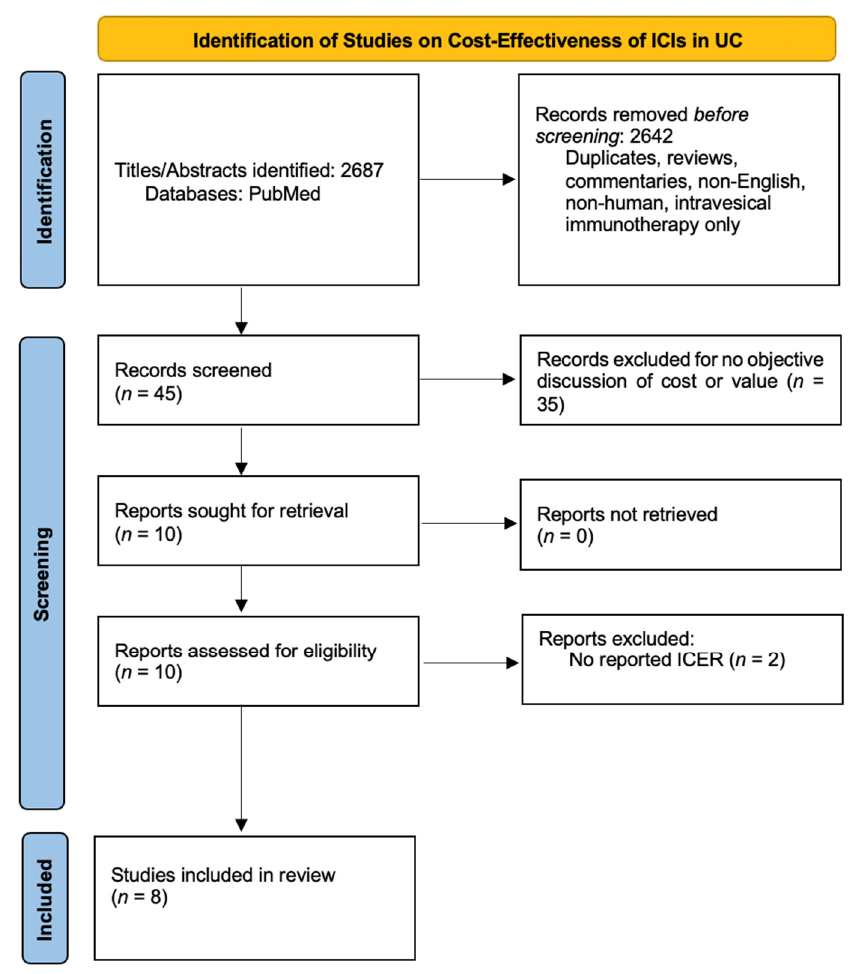
Figure 1. Selection and review of relevant CEAs for ICI in UC.